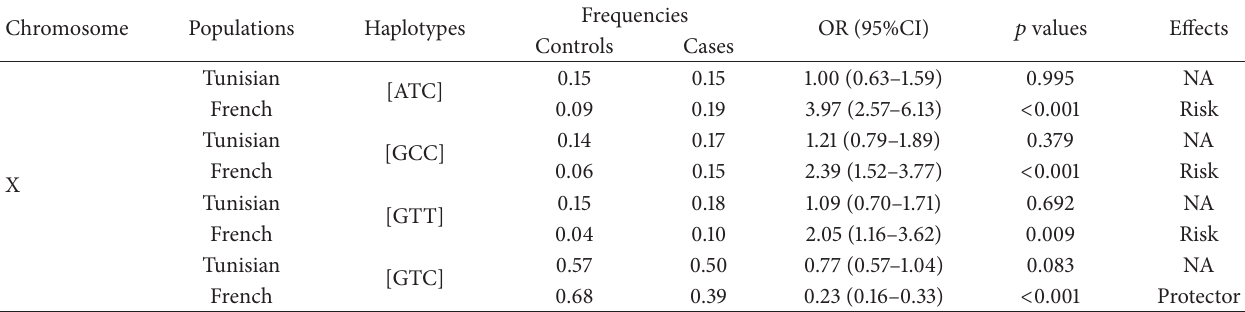
Table 6: Association of SNP haplotypes in the TMEM187-IRAK1 region with RA susceptibility.